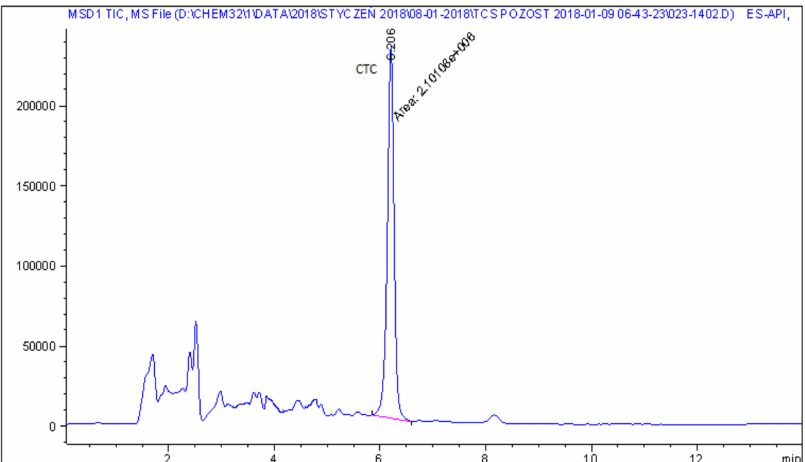
Figure 4. LC − MS chromatogram of real non-medicated feed sample with chlortetracycline at a concentration of 2.6 mg kg − 1 .